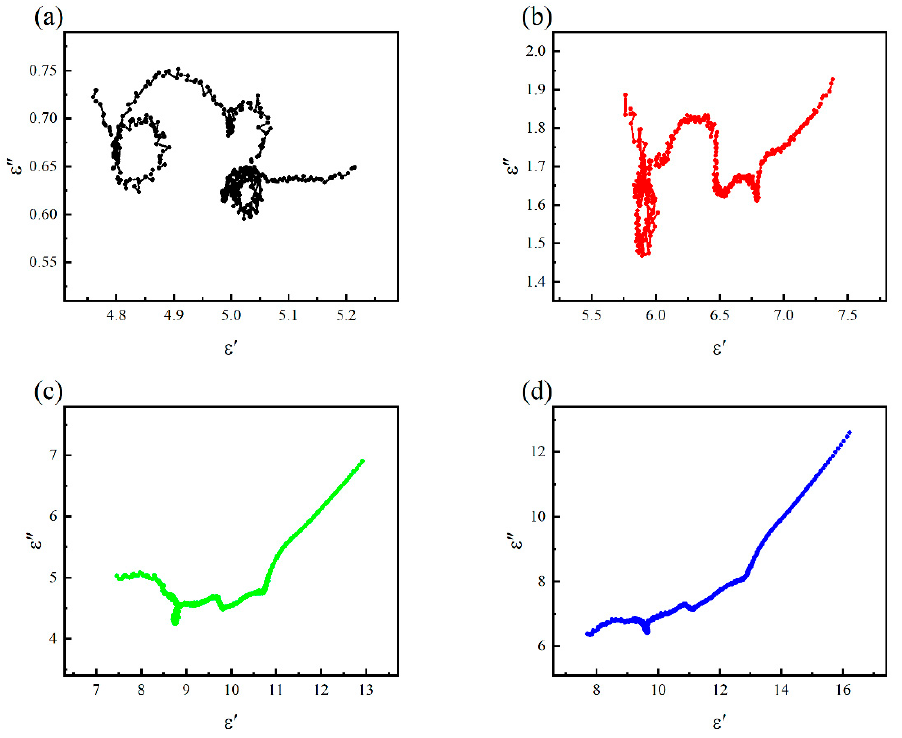
Figure 8. The ε (cid:48) − ε (cid:48)(cid:48) curves of all composites. ( a ) The ε (cid:48) − ε (cid:48)(cid:48) curve of CNC; ( b ) The ε (cid:48) − ε (cid:48)(cid:48) curve of Figure 8. The 𝜀 (cid:4593) − 𝜀 (cid:4593)(cid:4593) curves of all composites. ( a ) The 𝜀 (cid:4593) − 𝜀 (cid:4593)(cid:4593) curve of CNC; ( b ) The 𝜀 (cid:4593) − 𝜀 (cid:4593)(cid:4593) curve of CNCG-1; ( c ) The 𝜀 (cid:4593) − 𝜀 (cid:4593)(cid:4593) curve of CNCG-2; ( d ) The 𝜀 (cid:4593) − 𝜀 (cid:4593)(cid:4593) curve of CNCG-3. CNCG-1; ( c ) The ε (cid:48) − ε (cid:48)(cid:48) curve of CNCG-2; ( d ) The ε (cid:48) − ε (cid:48)(cid:48) curve of CNCG-3.